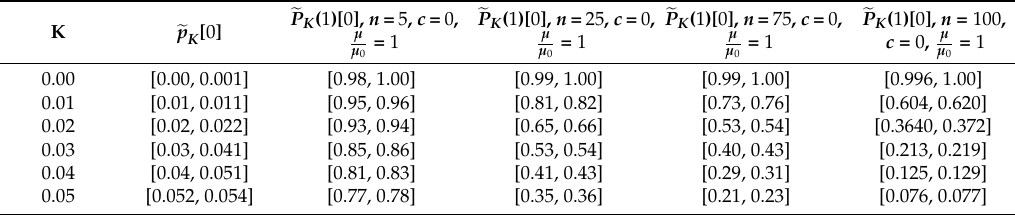
Table 2. Fatigue life data of aluminum